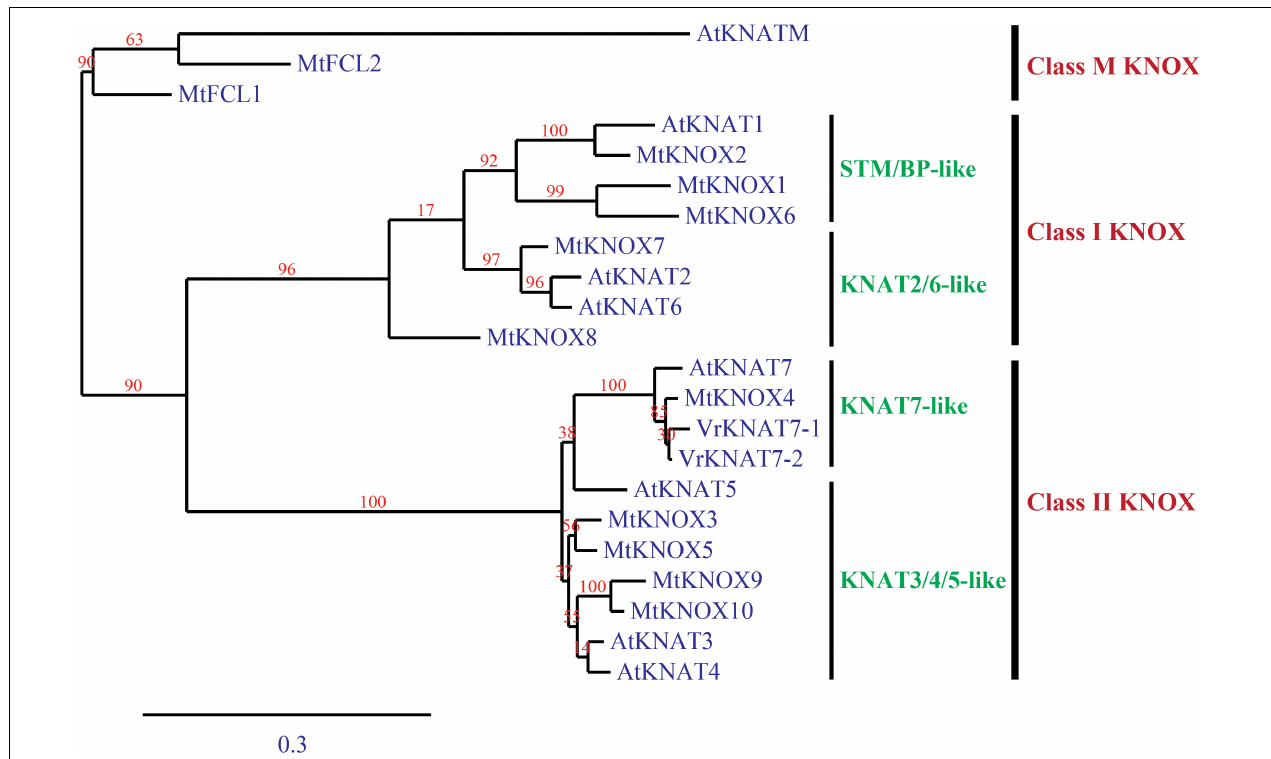
FIGURE 8 | A phylogenic tree of Vigna radiata KNAT7-1 and KNAT7-2 proteins, and Arabidopsis thaliana and Medicago truncatula KNOX proteins. The tree is constructed by a maximum-likelihood method.